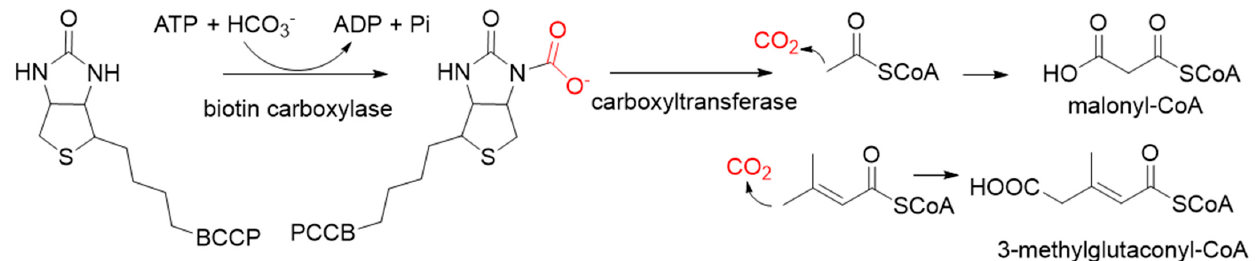
Figure 2. The catalytic process of biotin-dependent carboxylases [33–35].